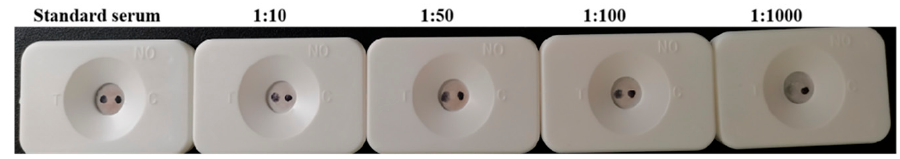
Figure 15. Silver staining results.